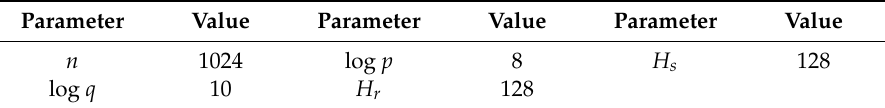
Table 2. The parameters used in this work (for 128-bit